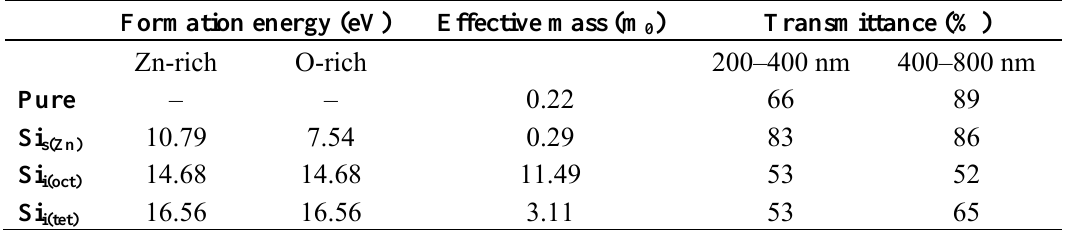
Table 1. Formation energy, effective mass, and average transmittance of pure and Si-doped ZnO.